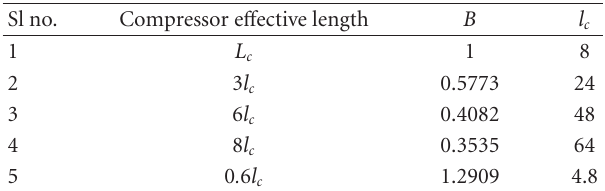
Table 2: Di ff erent compressor e ff ective lengths with respect to B = 1 and l c = 8